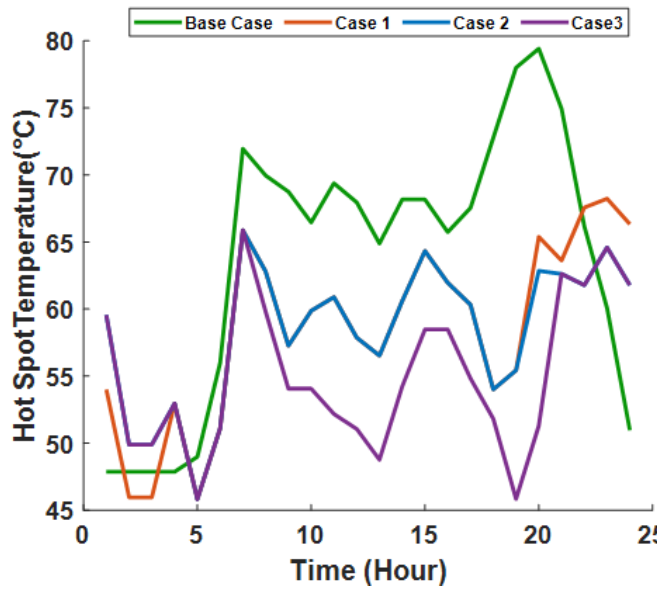
Figure 10. The impact of the DR on distribution transformer hot spot temperature (HST).